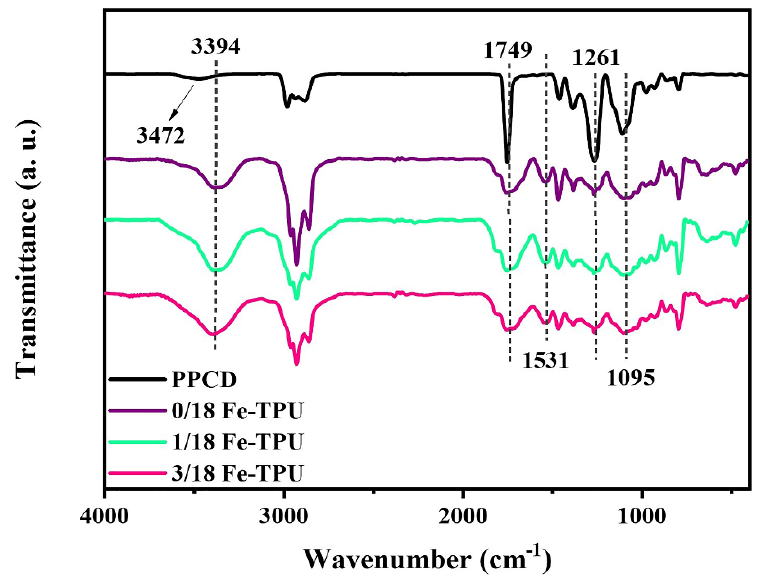
Figure 2. FT − IR spectra of TPU.